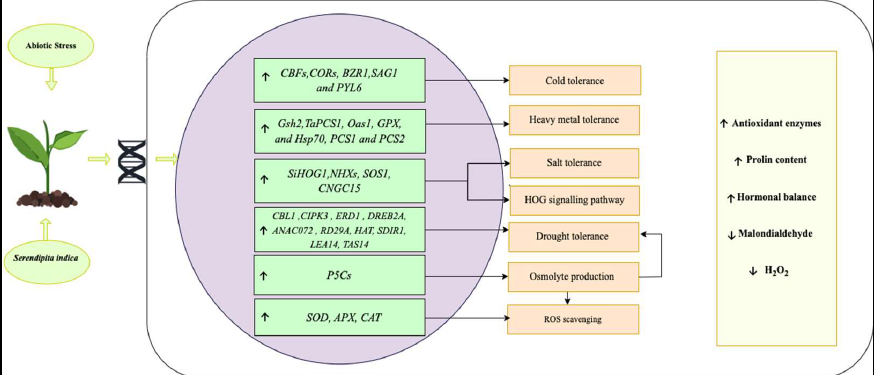
Figure 7. Schematic description of the effects and the molecular mechanisms of S. indica on host plants under various abiotic stress. Cold tolerance genes: BZR1 —brassinazole-resistant, CBFs —C-repeat-binding factor, CORs— cold-regulated genes, PYL6 —pyrabactin resistance 1-like, SAG1 s— senescence-associated gene; Drought tolerance genes: ANAC07 —transcription factor gene, CBL1 —